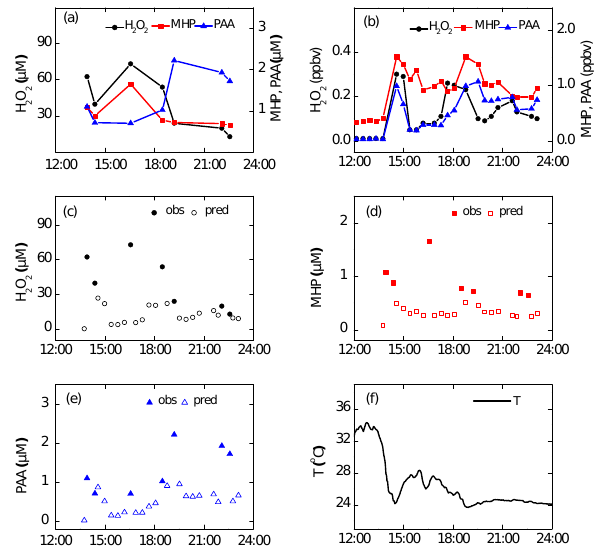
Fig. 4. Time series of gas phase and rainwater peroxides on 24 July 2011. (a) Observed peroxides in rainwater. (b) Observed per- oxides in the gas phase. (c) – (e) Comparisons of gas phase perox- ides observed (solid symbol) and predicted (open symbol) based on Henry’s law. (f)